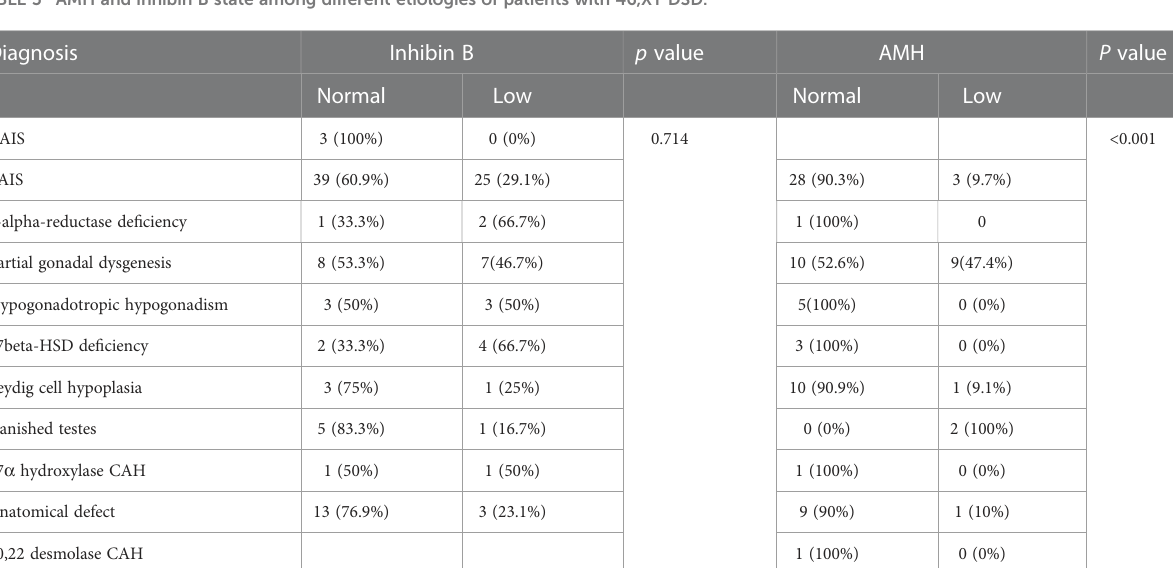
TABLE 5 AMH and inhibin B state among different etiologies of patients with 46,XY DSD.